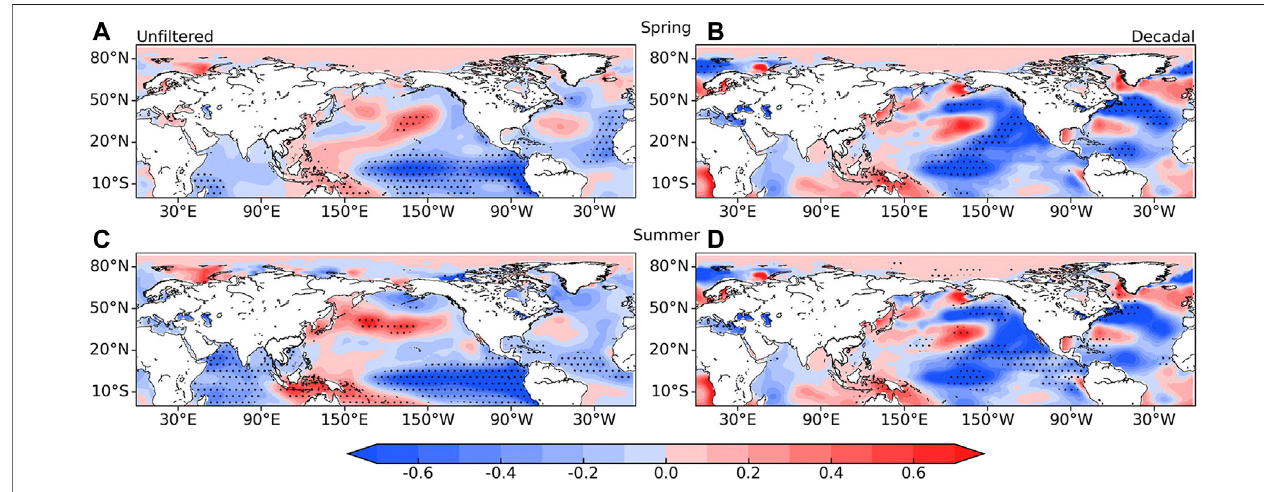
FIGURE7| Regression maps of SST anomalies (unit: ° C) during (A) spring and ( B ) summer against un fi ltered time series of LMP indices. (C , D) as in (A , B) , but for the decadal time series of LMP indices. Stippling indicates regression coef fi cients that are statistically signi fi cant at the 90% con fi dence level.